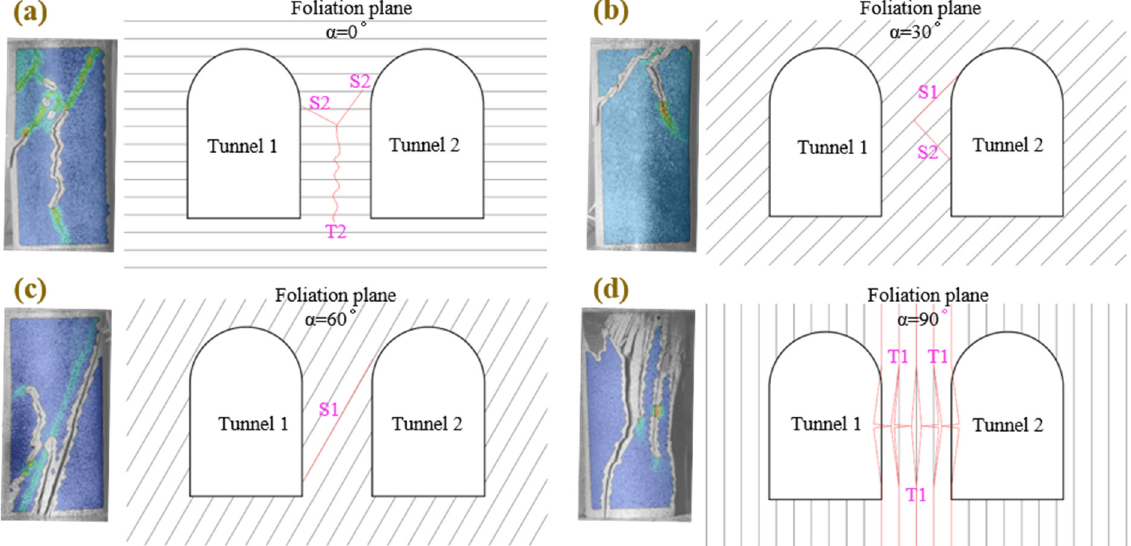
Figure 13. Comparison of failure mechanisms between foliated phyllite with different: ( a ) Shear sliding-tensile splitting across foliation planes (Mode Ⅰ ); ( b ) Shear sliding across foliation planes (Mode Ⅱ ); ( c ) Shear sliding along foliation planes (Mode Ⅲ ); ( d ) Tensile splitting along foliation planes (Mode Ⅳ ).